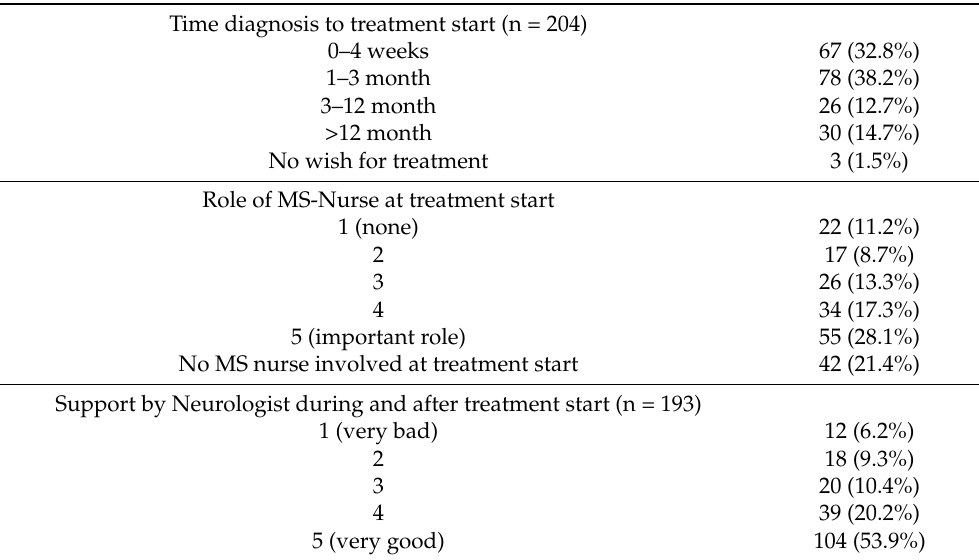
Table 3. Treatment start (n =